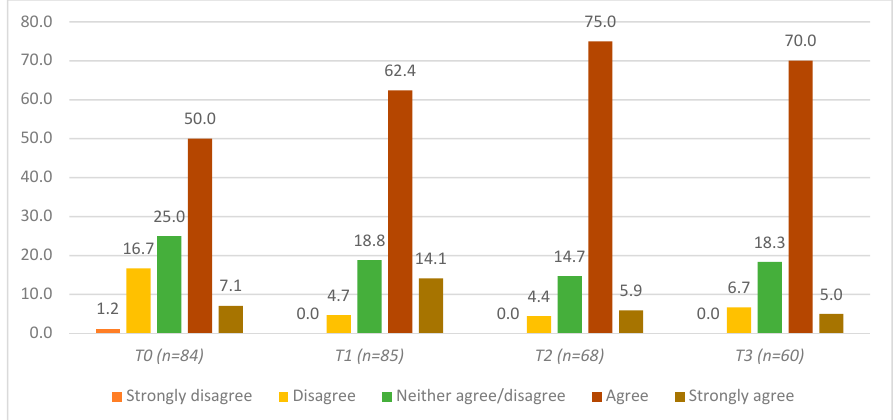
Figure 3. Self-assessment of confidence, if approached, in speaking to others about mental health in Figure 3. training (T0), post-training (T1), 3 months post-training (T2), and 6 months post-training (T3).